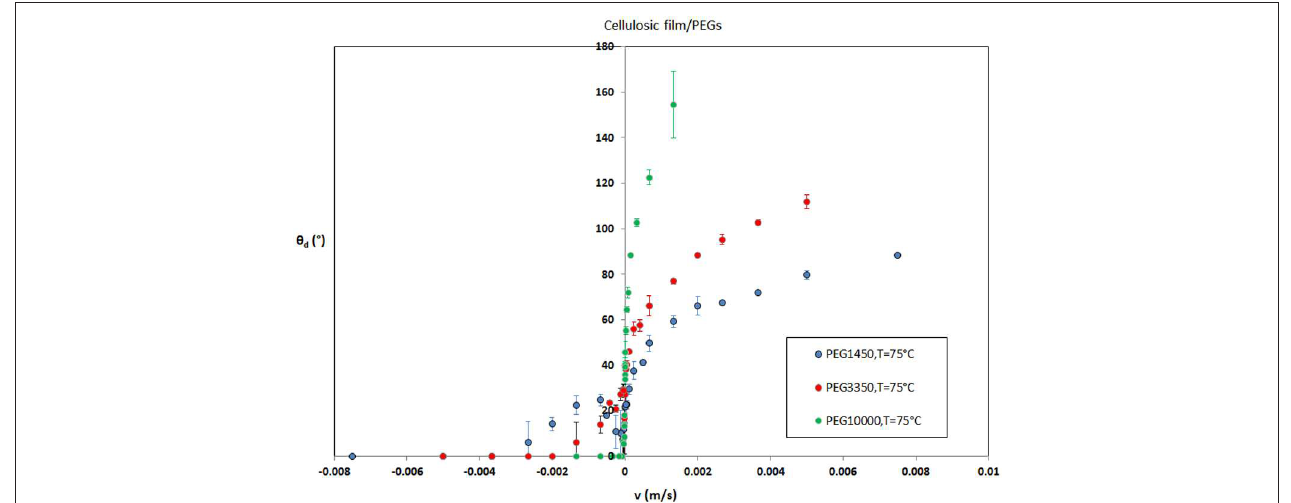
FIGURE 6 | Dynamic contact angles as a function of the immersion and withdrawal velocity.